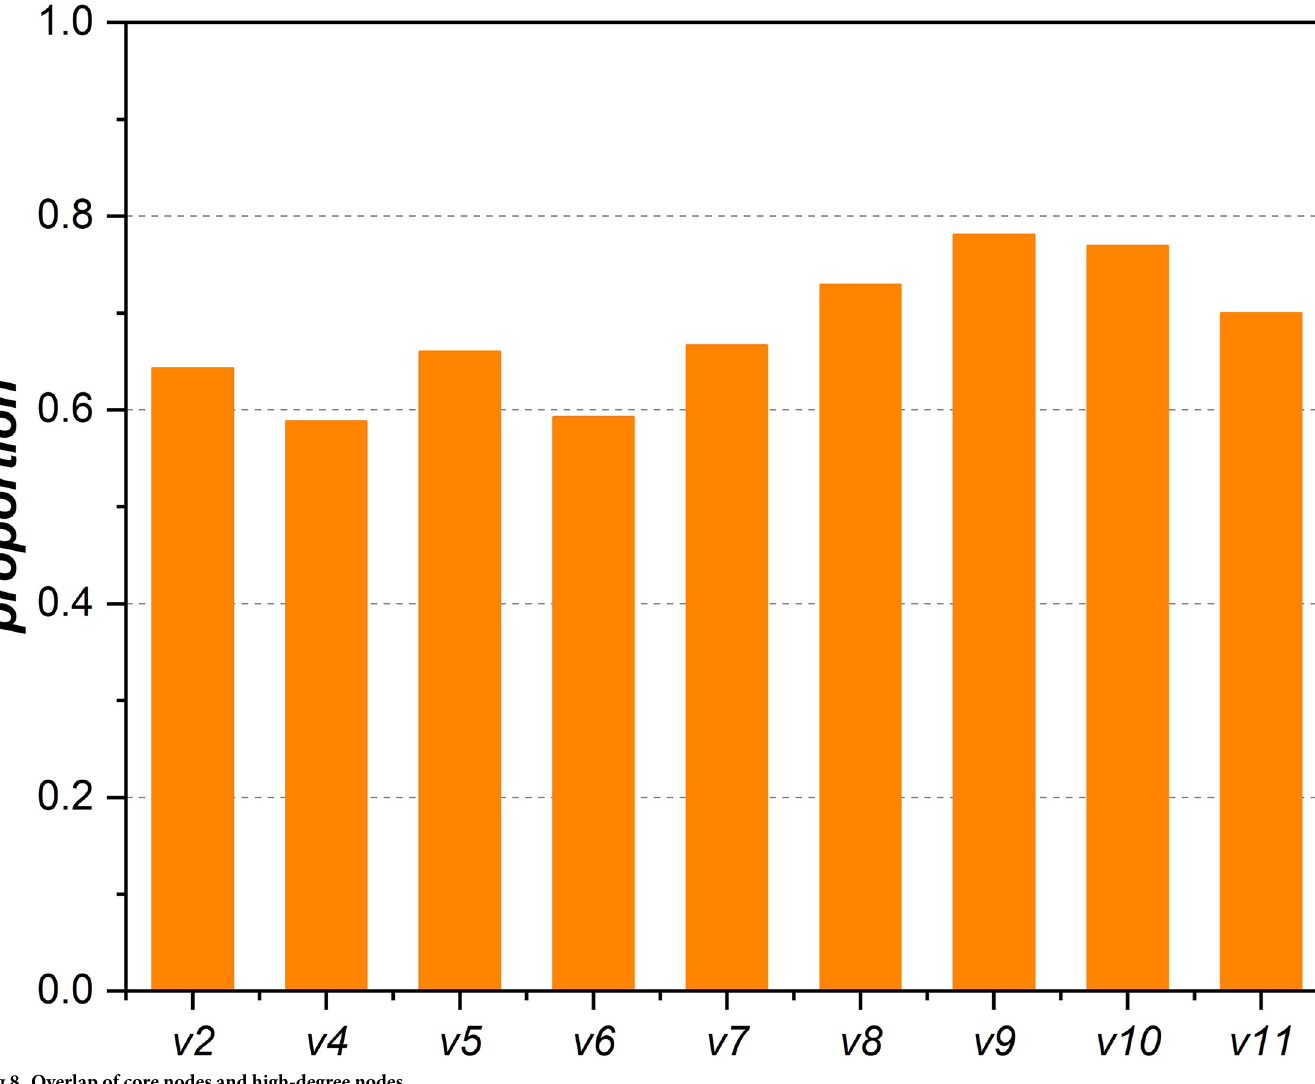
Fig 8. Overlap of core nodes and high-degree